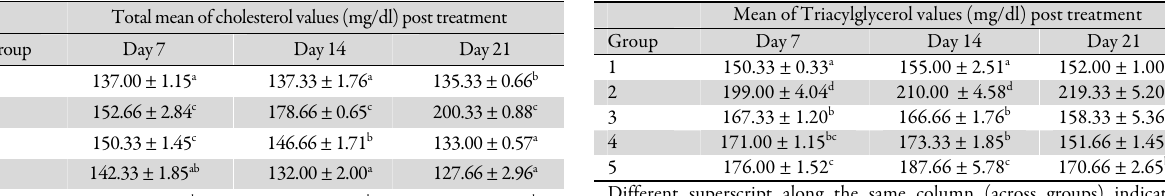
Different superscript along the same column (across groups) indicate significant difference at p < 0.05 Table 3. The total mean of cholesterol values of alloxan induced diabetic rats treated with combinations of glibenclamide and aqueous extract of G. latifolium